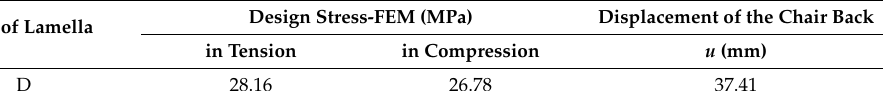
Table 6. Values of design compression and tensile stresses and values of the backward displacement of the chair back u (mm) in the case of the lamella type D when loading is 150 kg.